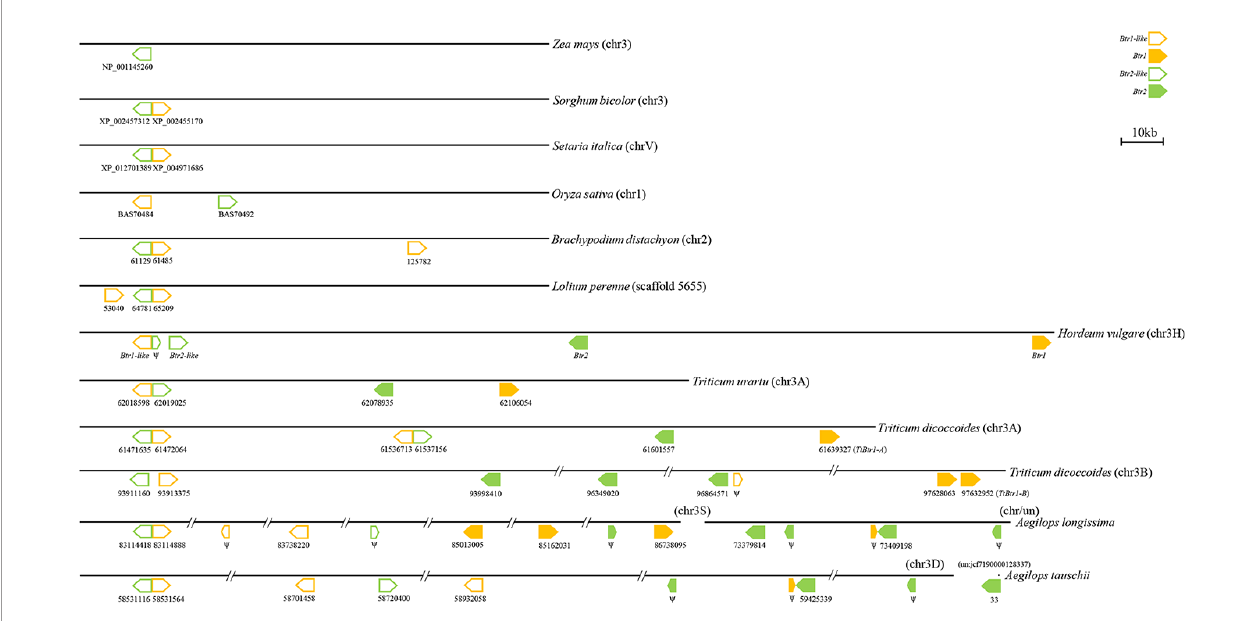
FIGURE 6 | Organization of Btr1 , Btr1-like , Btr2 , and Btr2-like genes in the grasses. The direction of translation is arrowed. Numbers indicate either the gene's ID or the nucleotide positions of the gene's translation start point. Only the chromosome 2 genes of B. distachyon are shown.